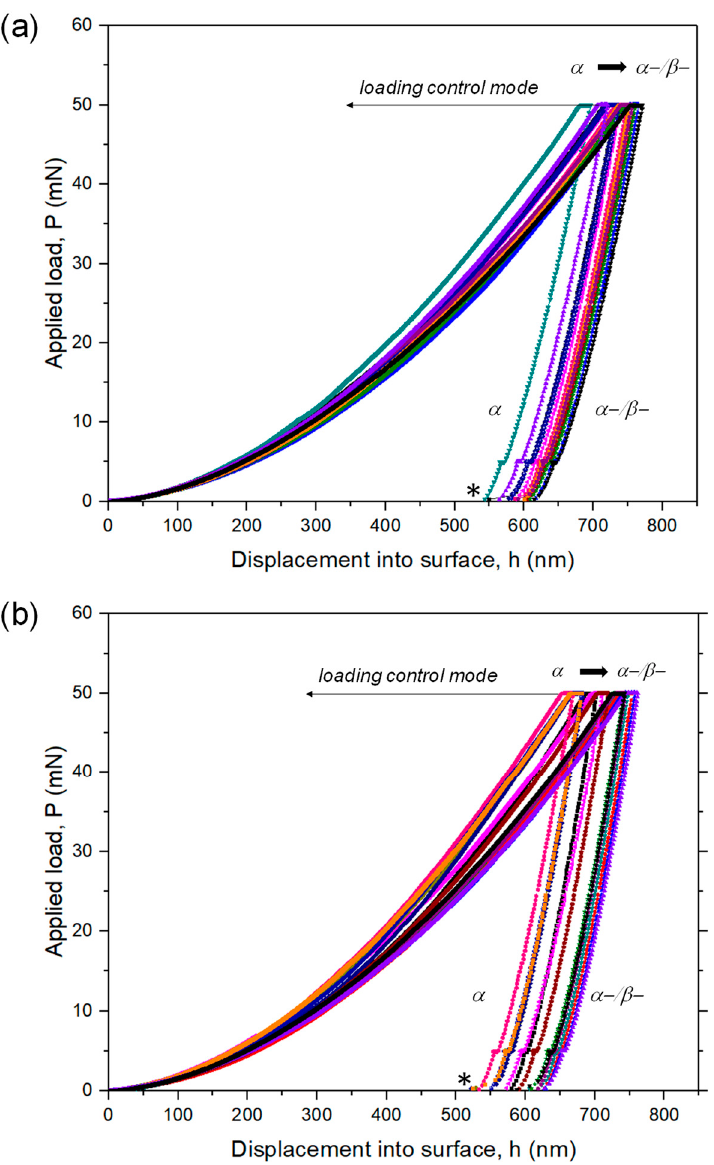
Figure 8. Indentation loading–unloading curves (or P–h curves) performed at 50 mN of maximum applied load for the ( a ) LD and ( b ) TD directions of the Ti-6Al-4V alloys.